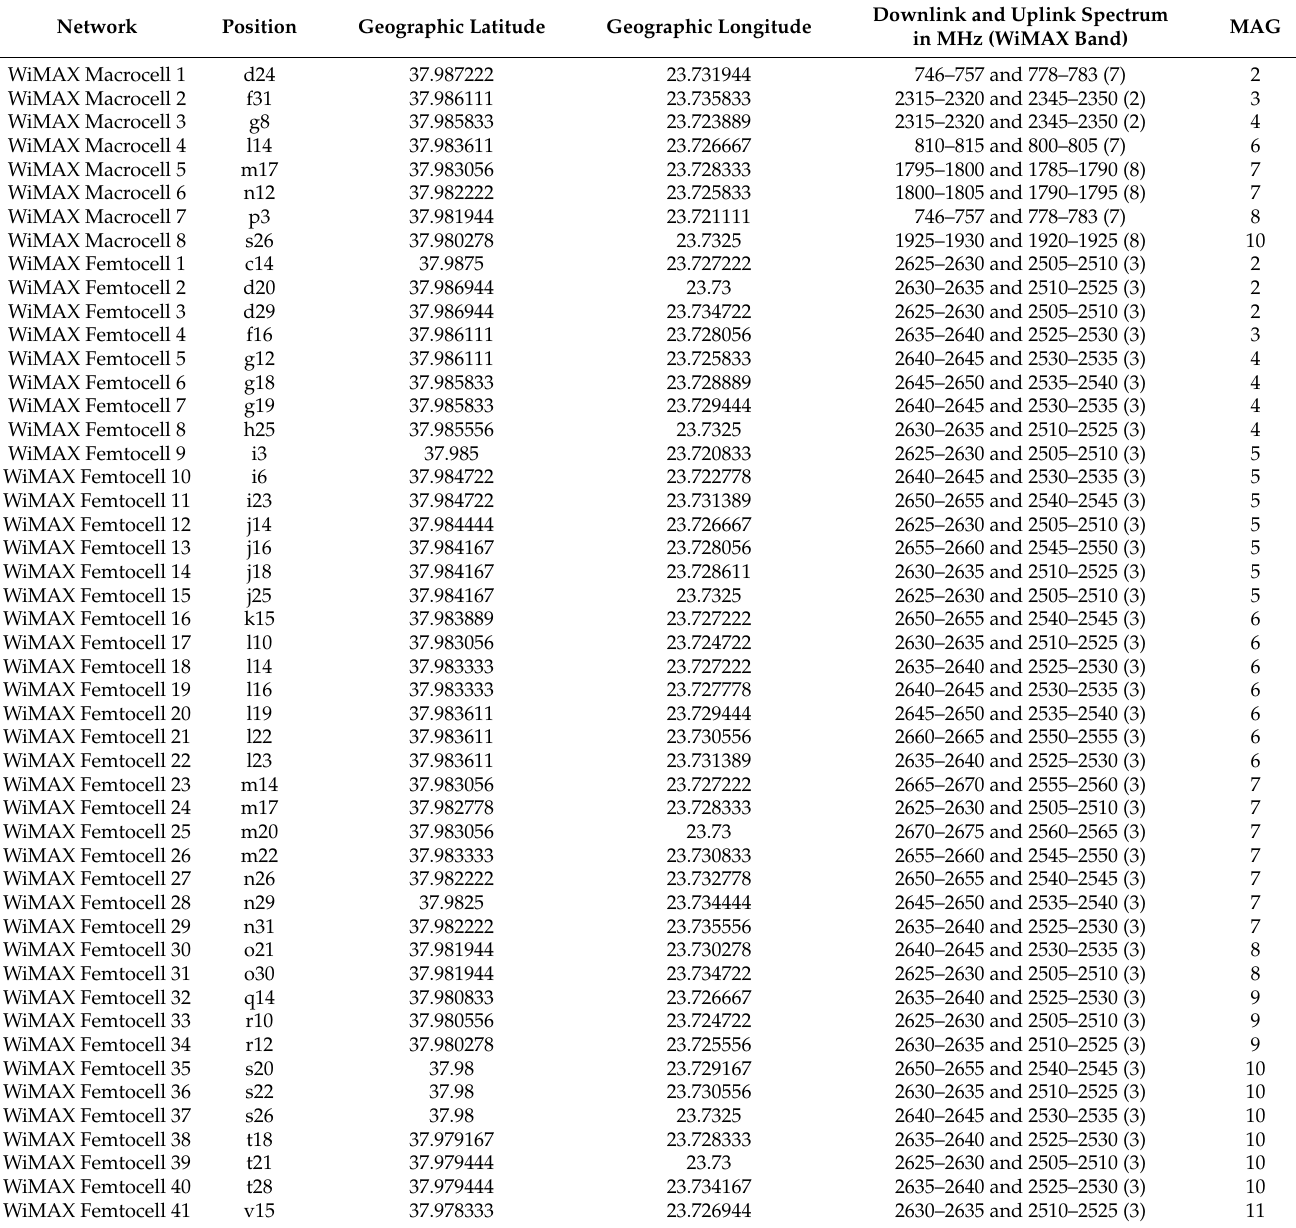
Table A4. The positions and the frequencies of the simulated WiMAX